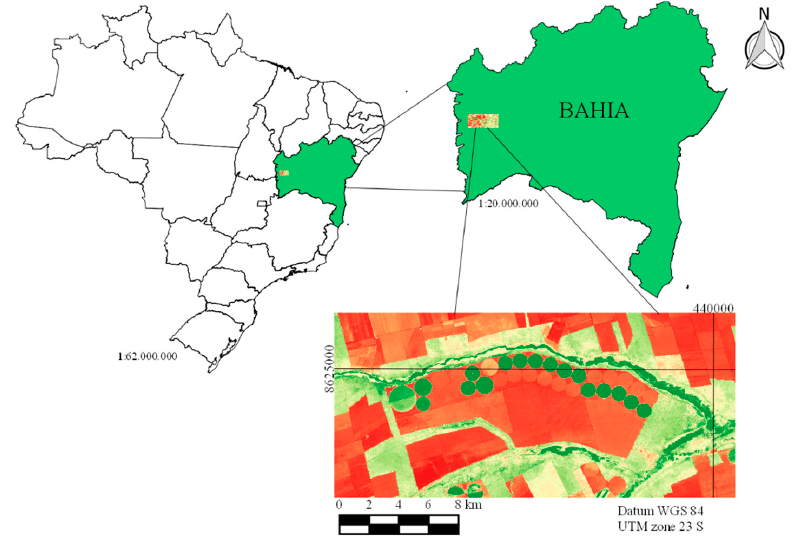
Figure 1. Location of the study area in relation to Brazil and the state of Bahia.